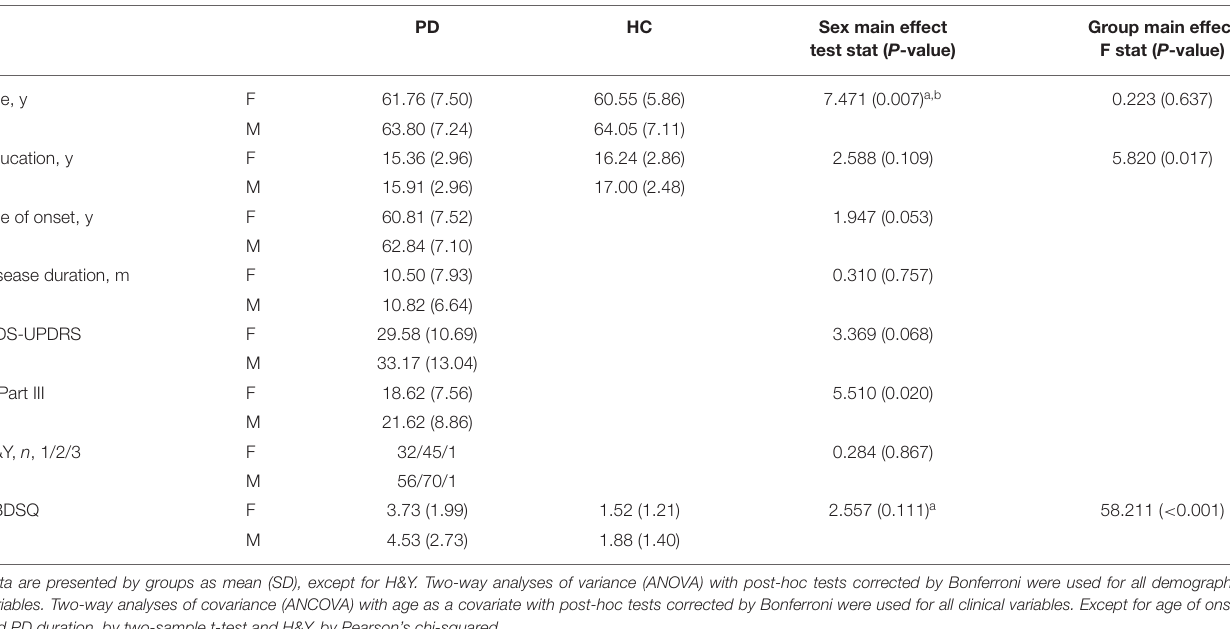
with larger disease duration (between 2.13 and 3.69 years) reported cortical thinning in PD males in the left precentral and right postcentral areas compared with PD females. As